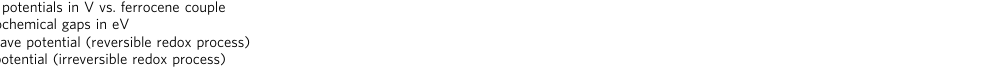
a Redox potentials in V vs. ferrocene couple b Electrochemical gaps in eV c Half-wave potential (reversible redox process) d Peak potential (irreversible redox process)